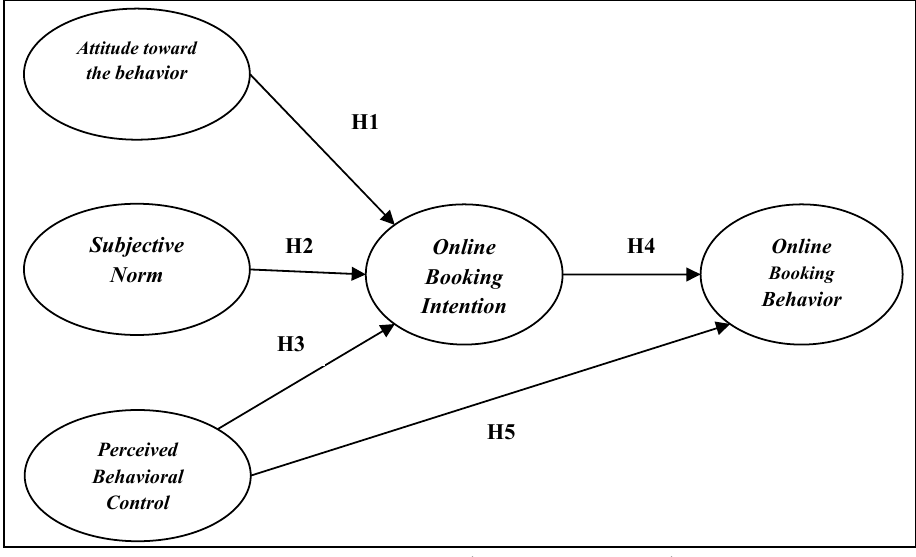
Fig. 1. Research Concept